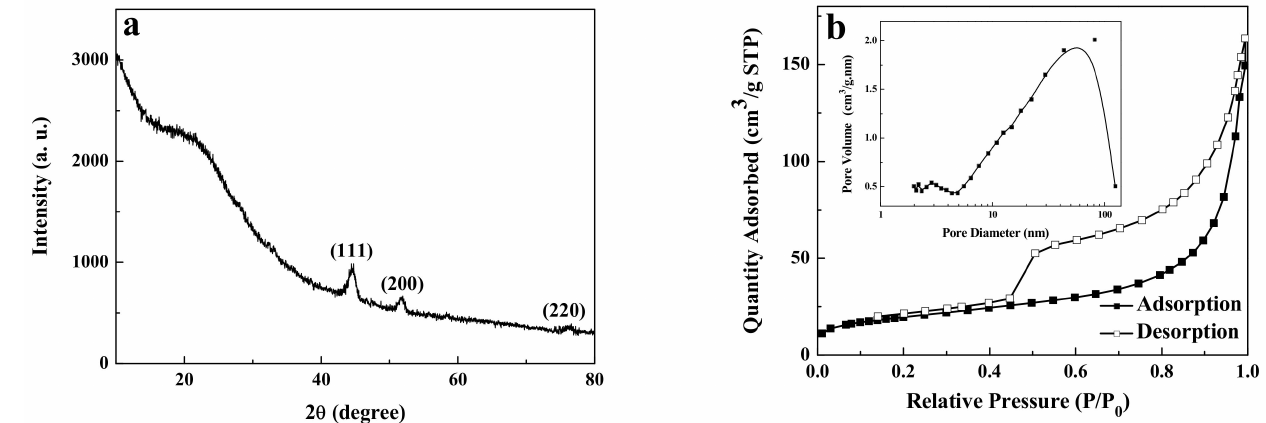
Figure 3. XRD pattern ( a ), and nitrogen adsorption–desorption isotherm and pore size distribution (inset) of carbon-supported metal nickel ( b ).